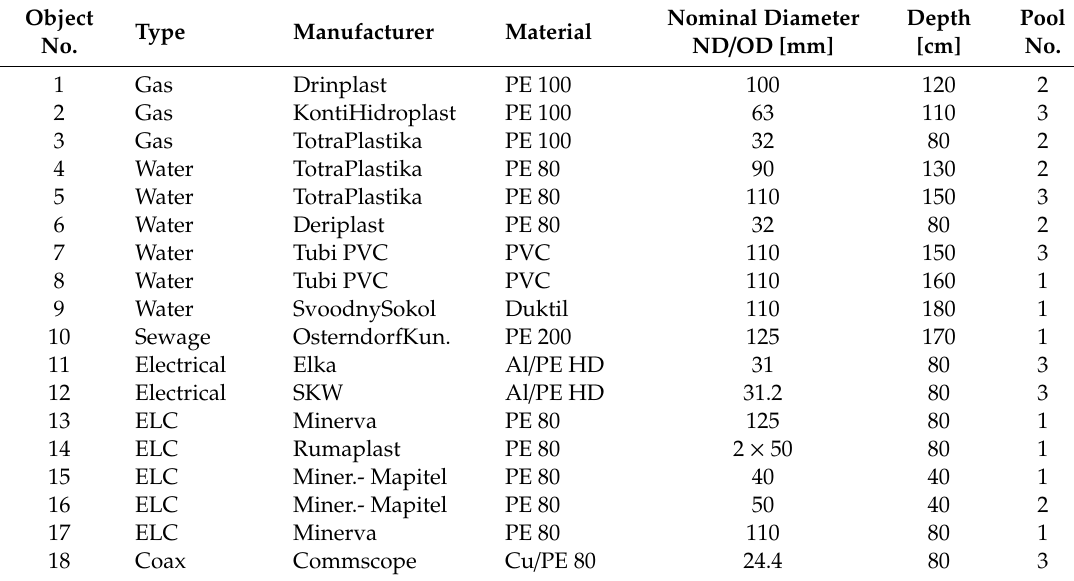
Table 1. A summary of all the buried pipes, electrical cables, electronic communication cable